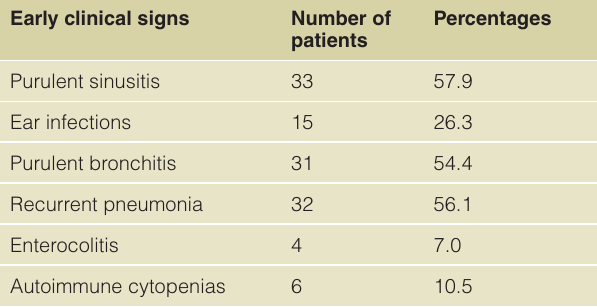
Table 1. Early clinical signs of CVID.